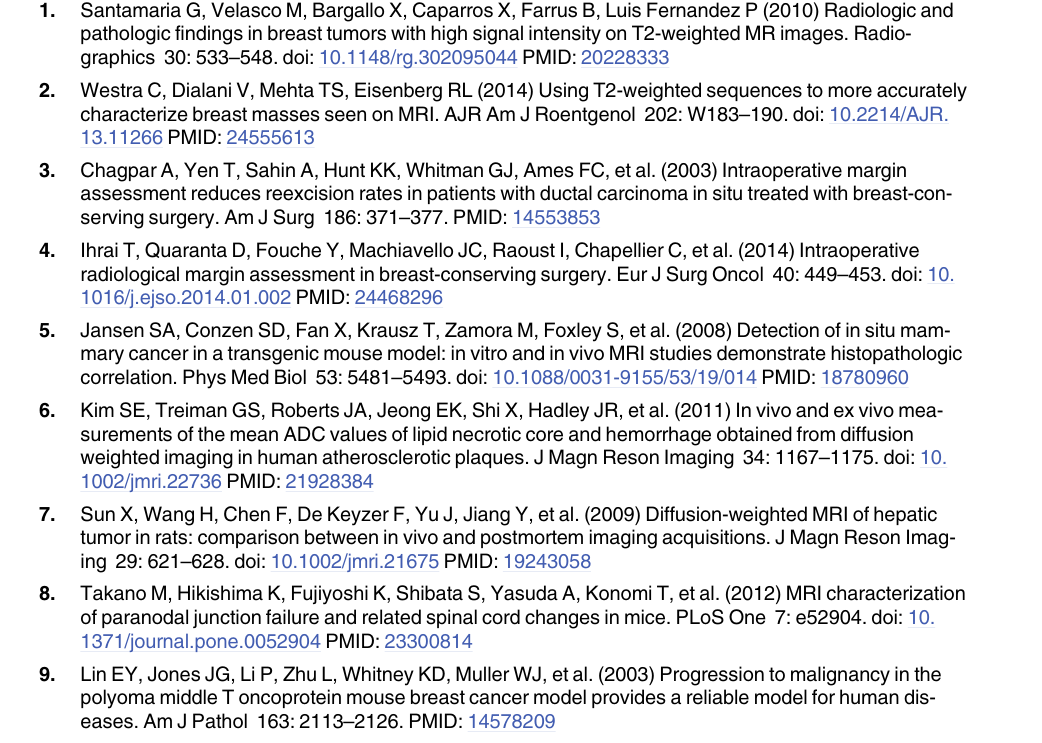
Fig 6. Plots of in vivo versus ex vivo average T 2 values over ROIs from 11 mice. (a) lymph nodes, (b) in situ cancers, and (c) invasive cancers. The gray line is the linear fit through the points. The linear relationship between in vivo and ex vivo T 2 s, the correlation coefficient (r) and p value are given on the plot.